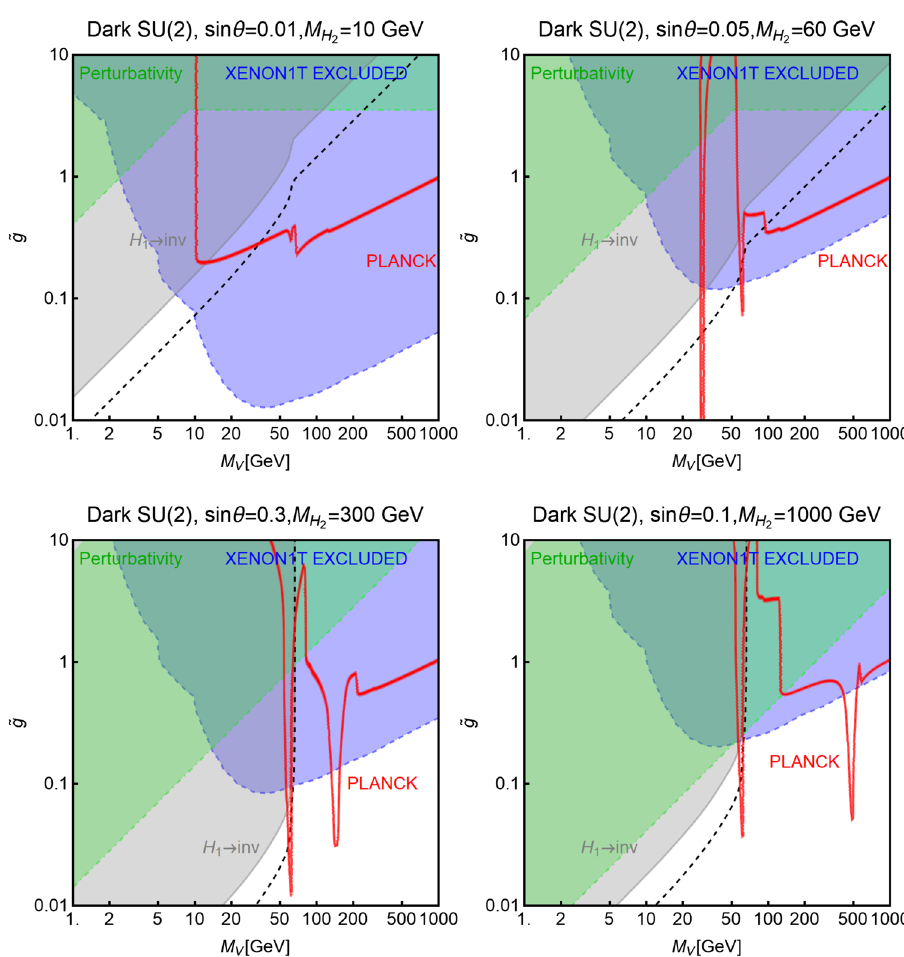
Fig. 17 The same as Fig. 12 but for the dark SU(2)